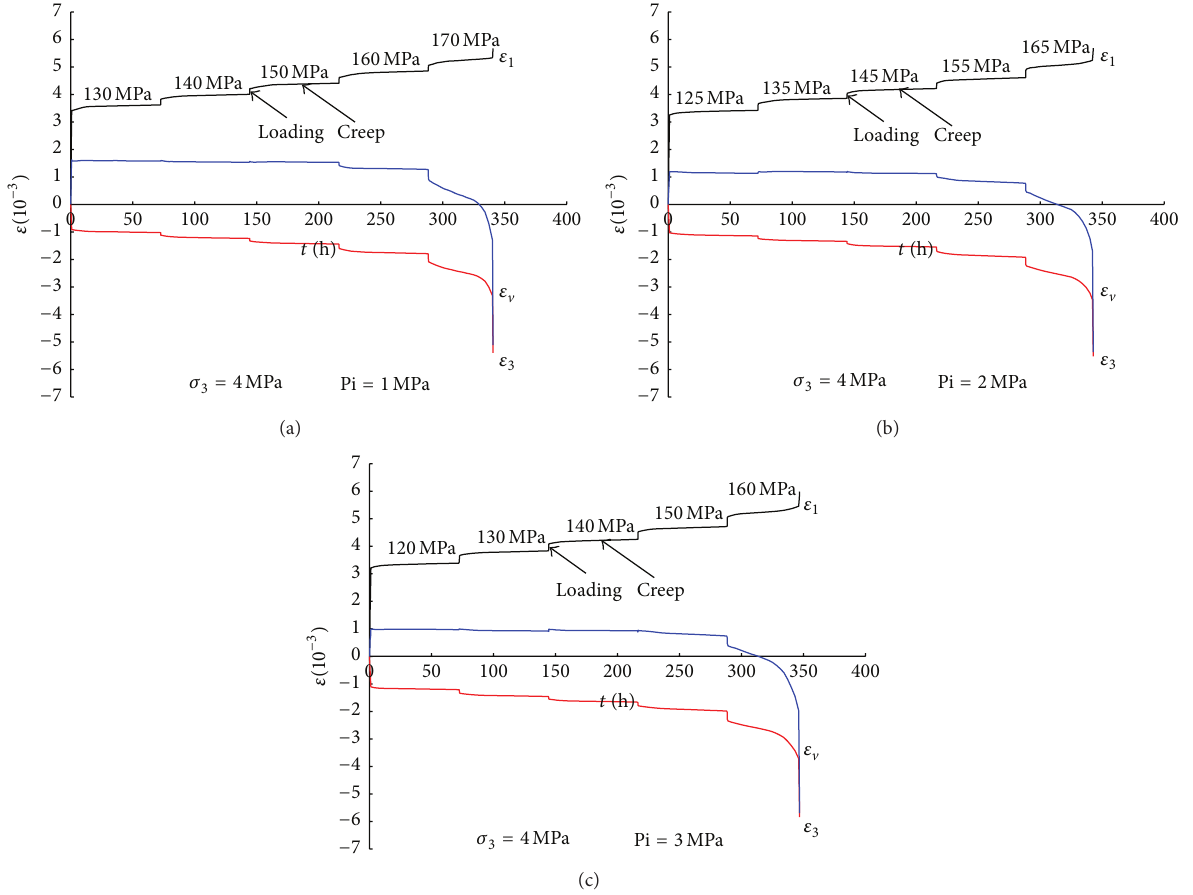
Figure 3: Triaxial creep test curves of granite gneiss: (a) 𝜎 3 = 4 MPa, Pi = 1 MPa; (b) 𝜎 3 = 4 MPa, Pi = 2MPa; (c) 𝜎 3 = 4 MPa, Pi = 3MPa.